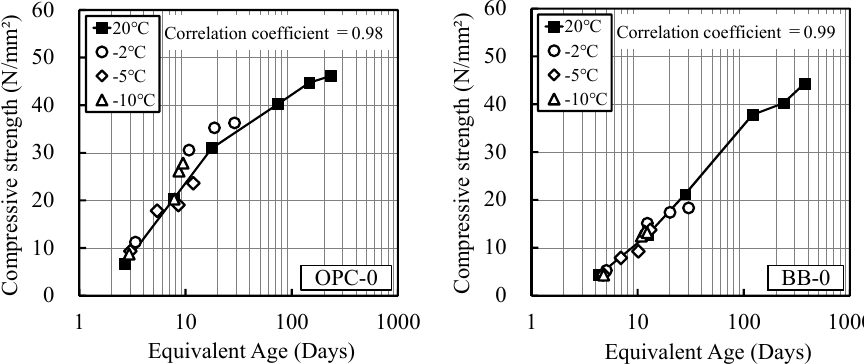
Figure8. Relationshipbetweenequivalentageandmeasuredcompressivestrengthconsideringfreezing. Figure 8. Relationship between equivalent age and measured compressive strength considering freezing.